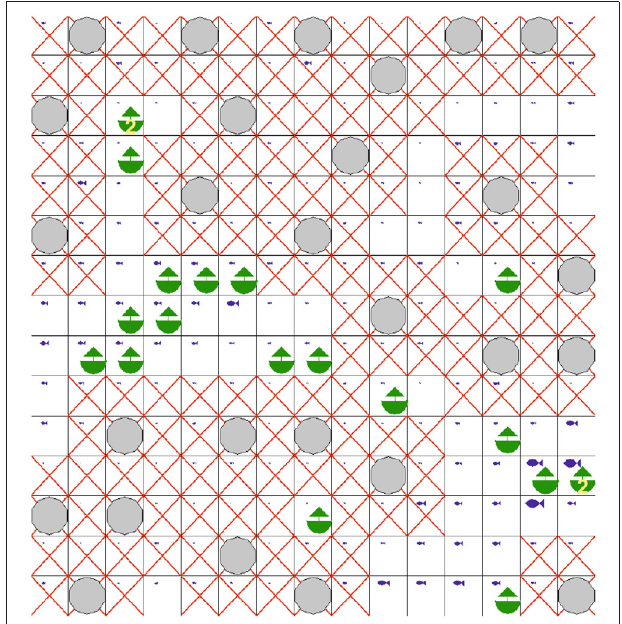
FIGURE 3 | The world map organized as a grid